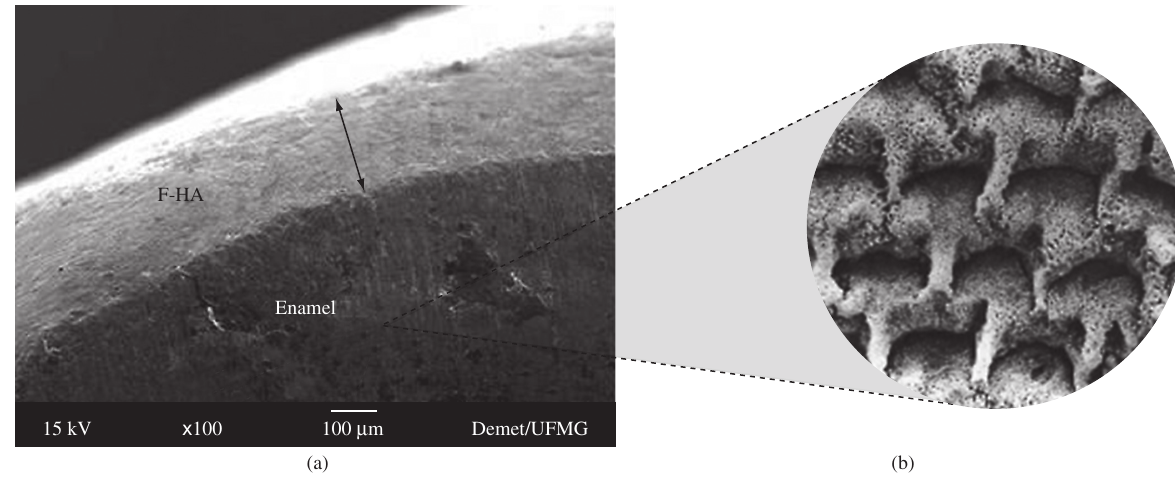
Figure 4. a) SEM image showing the thickness of the F-HA layer on the tooth bucal surface (arrow); and b) Insert detail: Adapted from